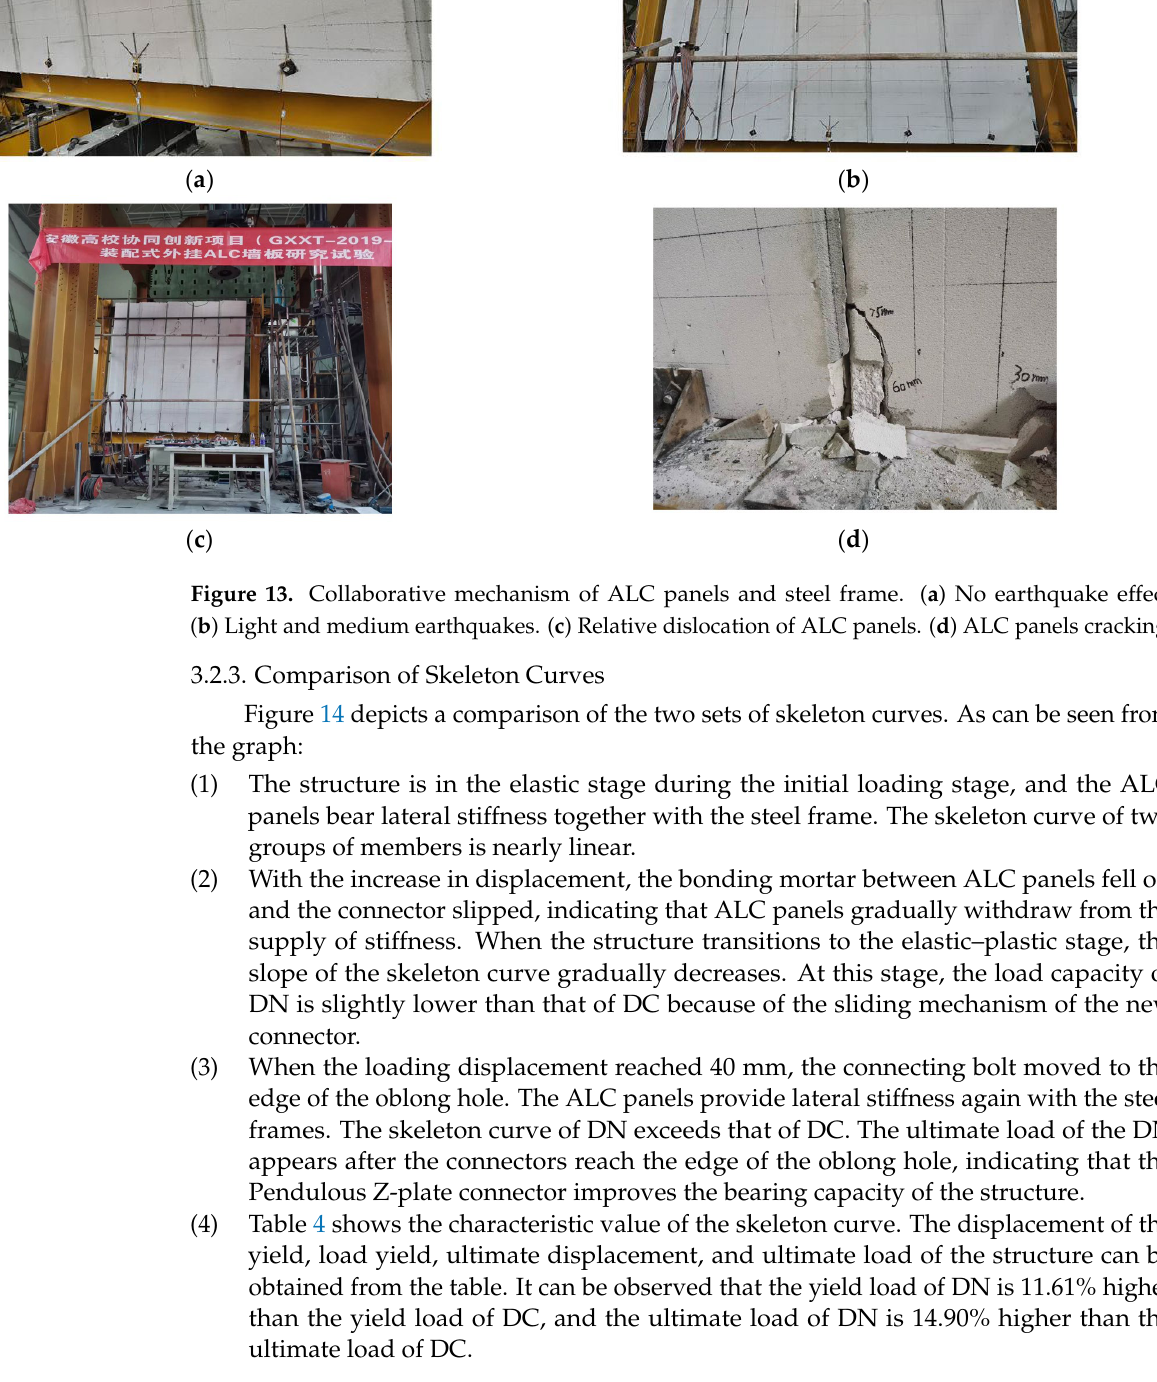
Table 4. Characteristic value of skeleton curves.